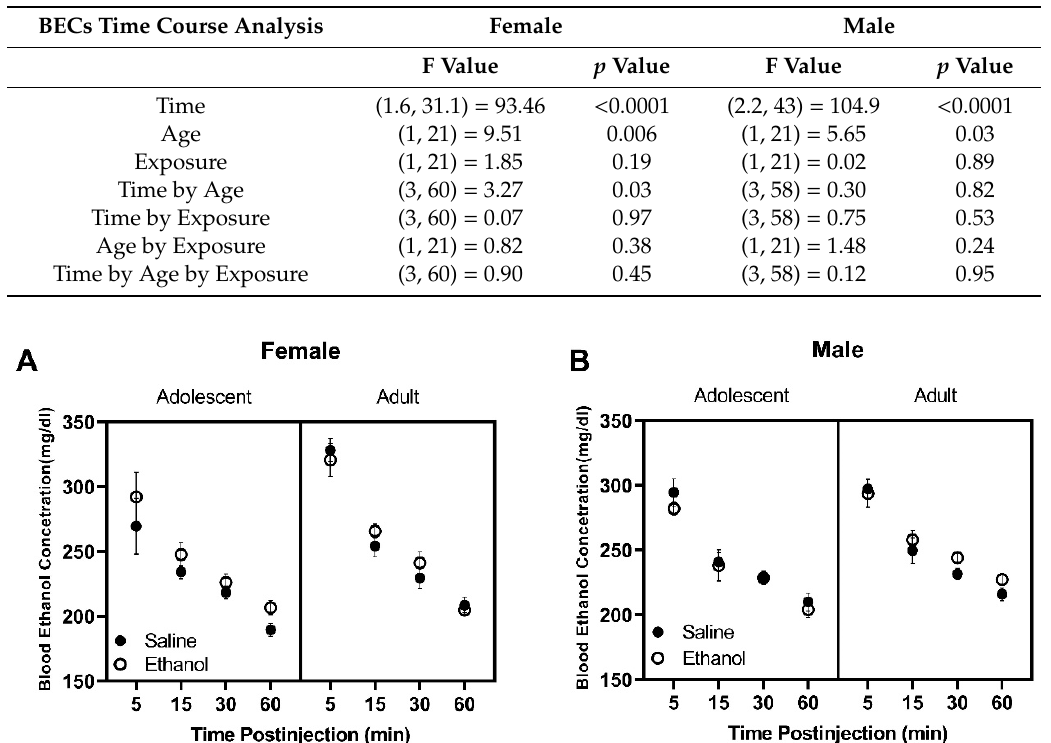
Table 9. Table for ANOVA results for blood ethanol concentration time course analysis data.